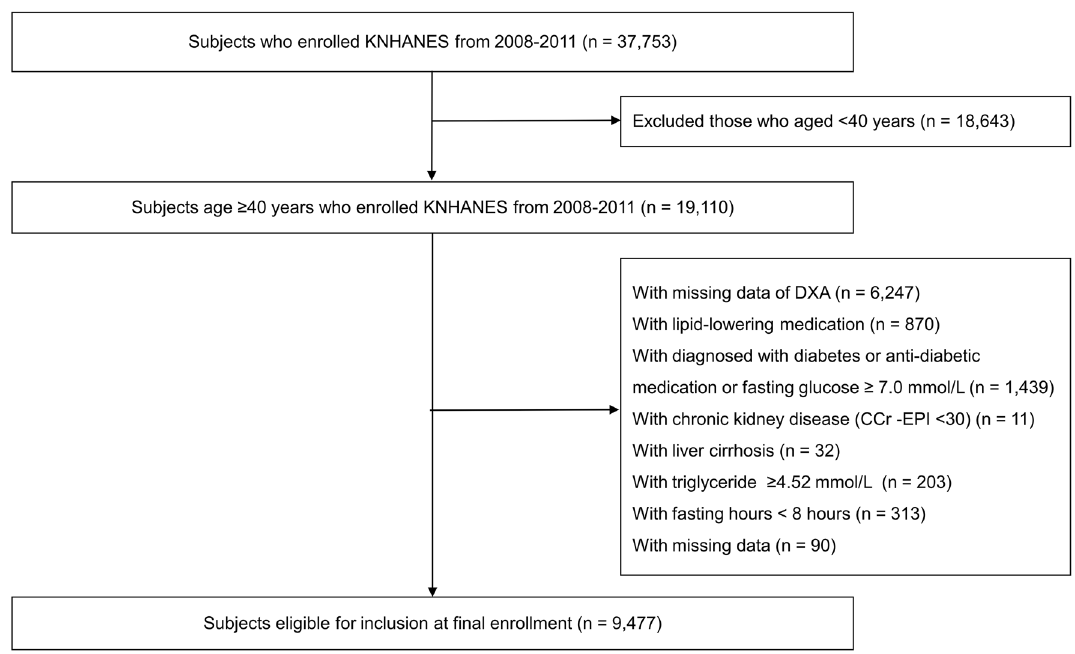
Figure 1. Flow chart of the study. DXA, Dual-energy X ‐ ray absorptiometry; KNHANES, Korea National Health and Nutrition Examination Survey; TyG index triglyceride-glucose